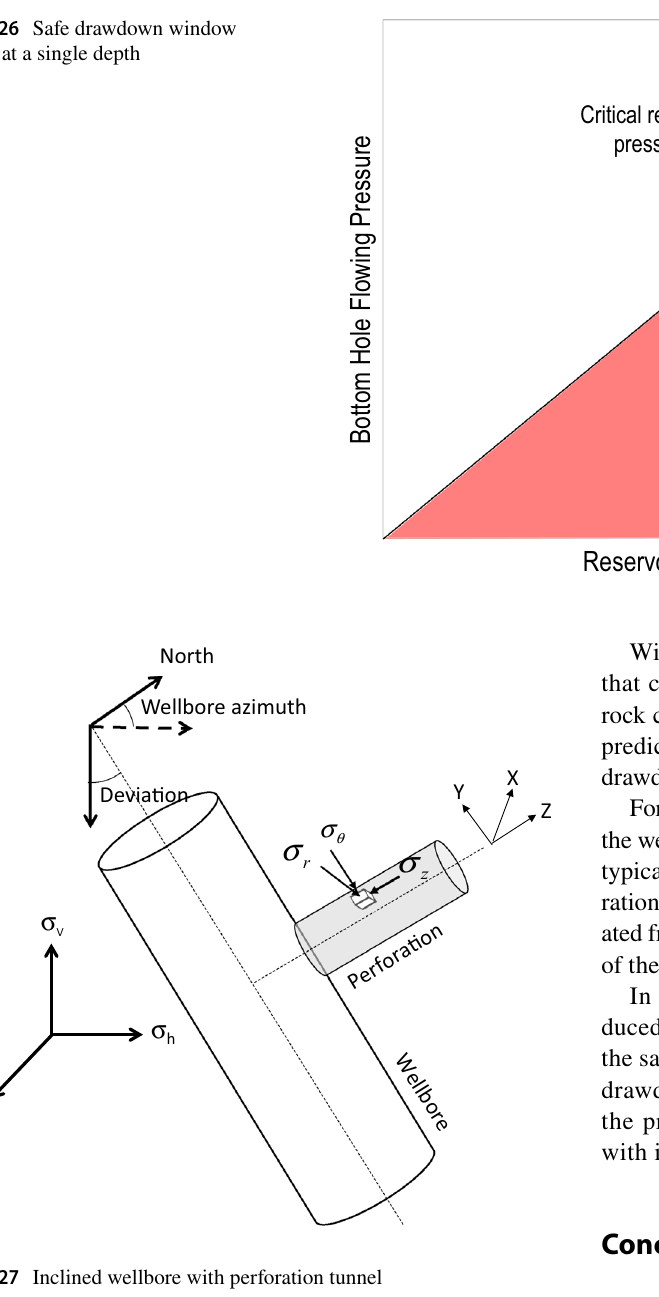
Fig. 27 Inclined wellbore with perforation